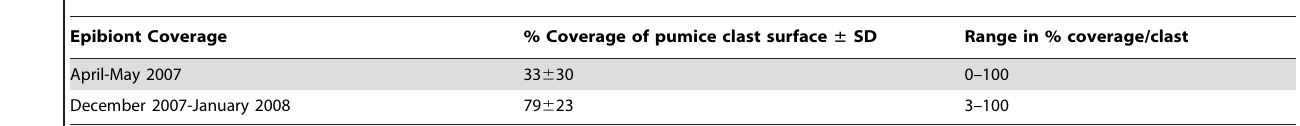
Table 4. Temporal variation in total epibiont coverage.